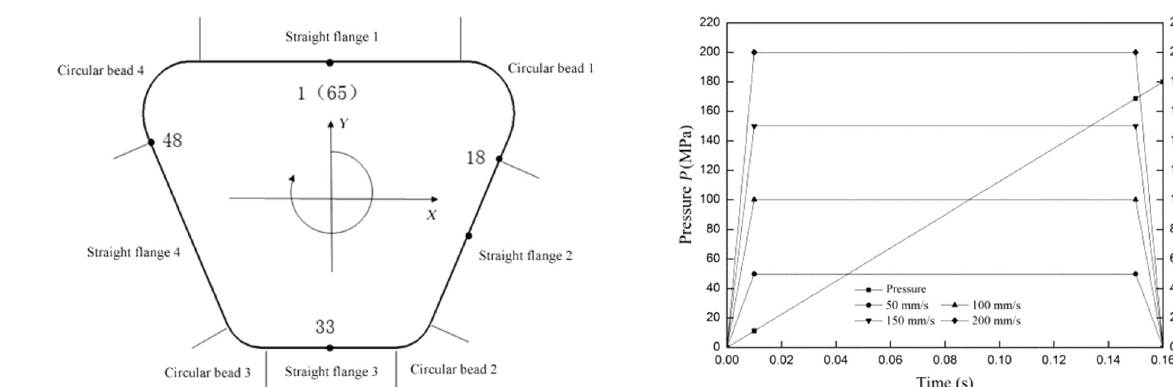
Figure 40 Load path with axial feed